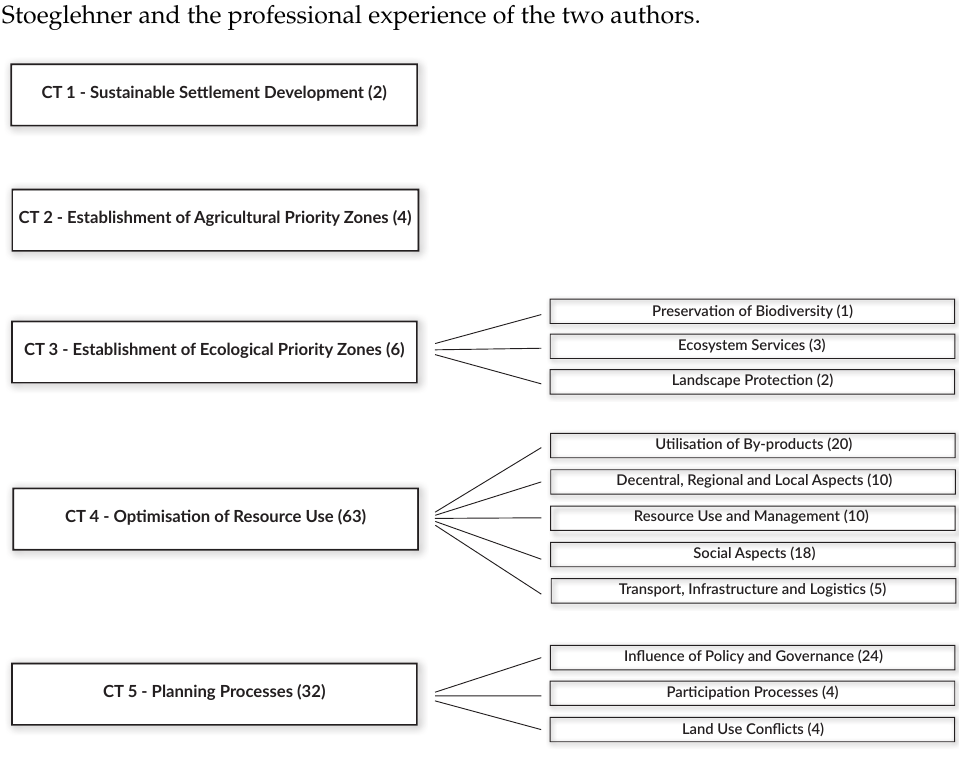
Figure 2. Assignment of the articles to the five core themes and respective number of